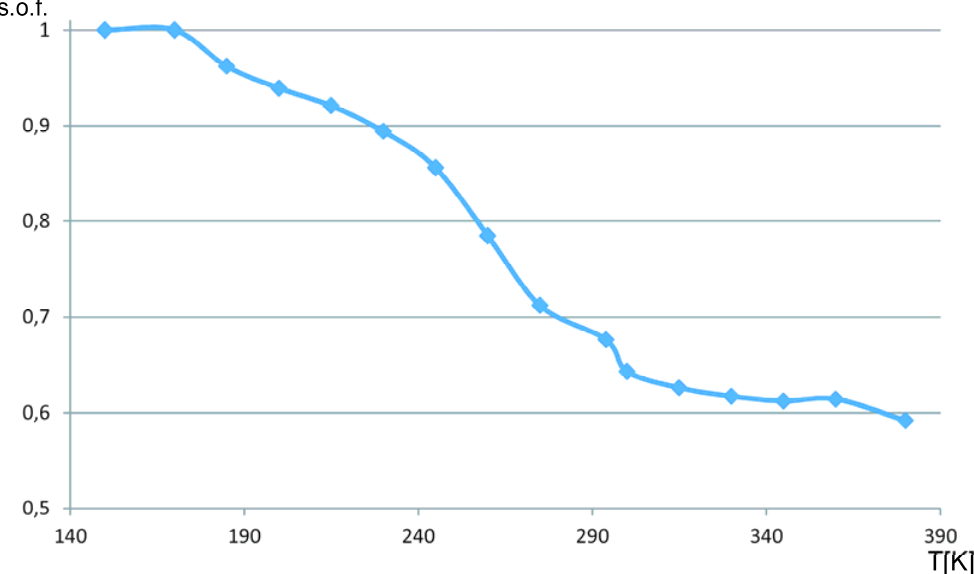
Figure 5. Temperature dependence of the site occupation factor of the higher-occupied methyl group (cf. Experimental